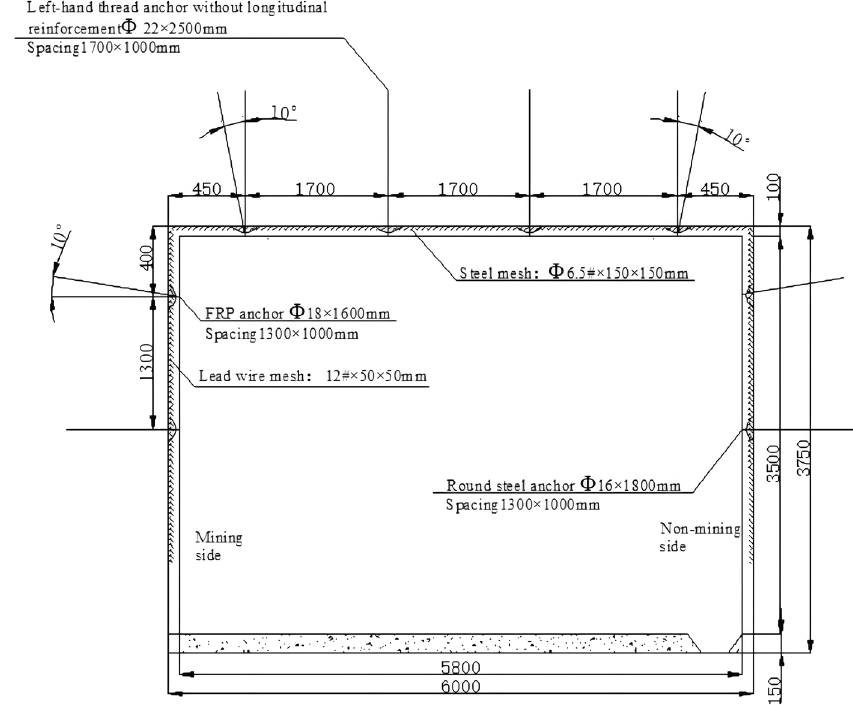
Figure 6. Roadway support drawing.